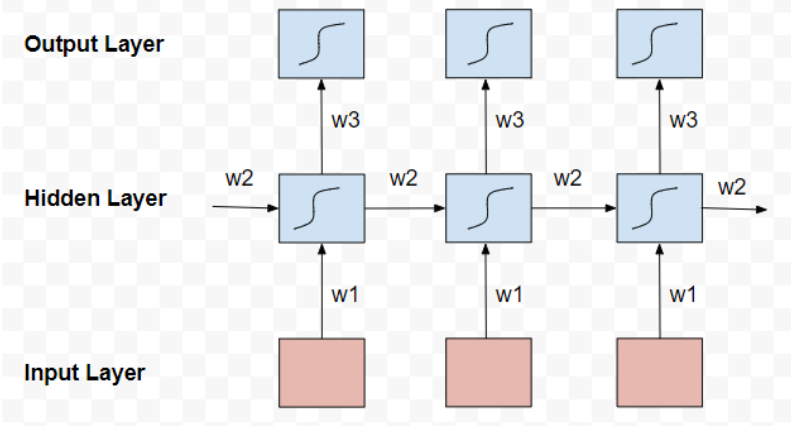
Figure 2. Unfolded recurrent neural network.